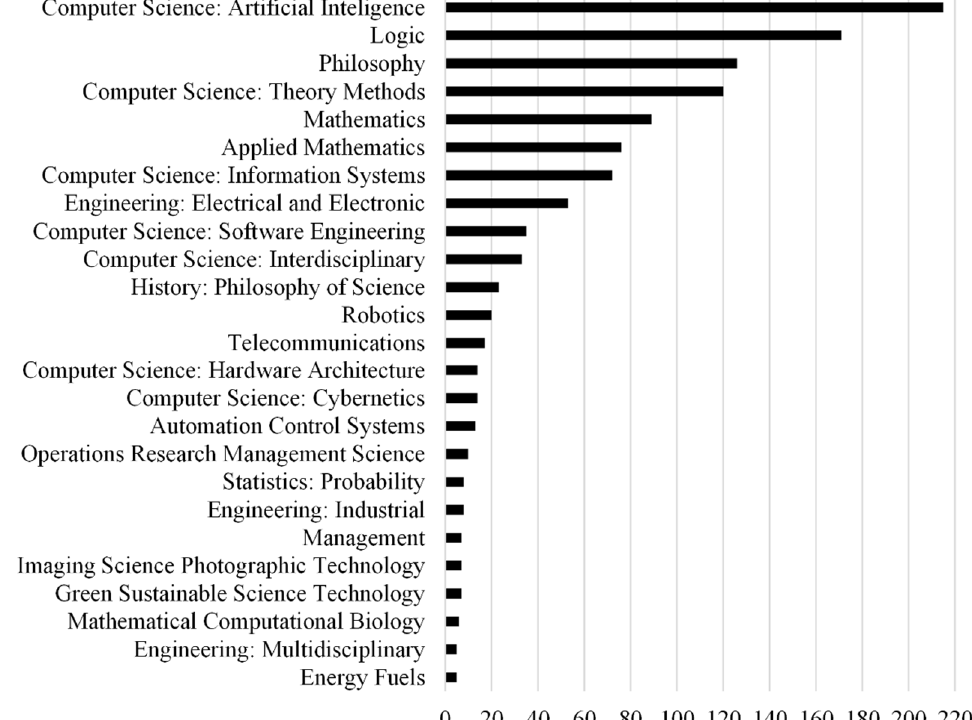
Figure 1. Number of articles found in the Web of Science database (May 2020) about Paraconsistent Annotated Logic (PAL), by application area.